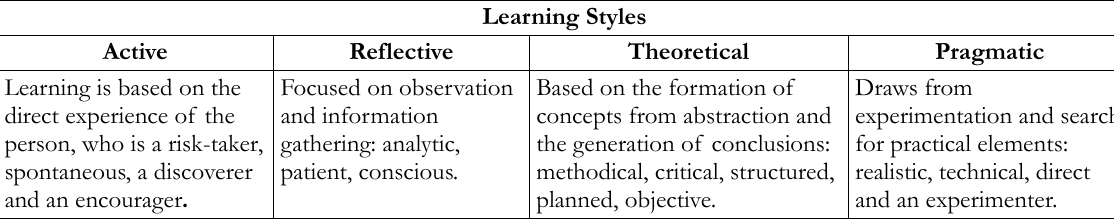
Table 4. Kolb’s experiential learning